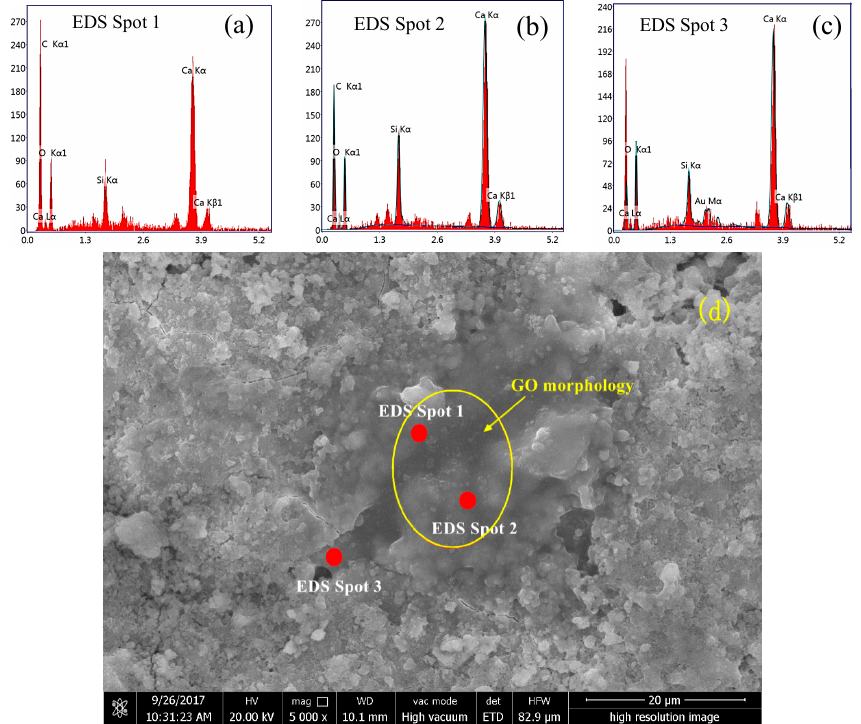
Figure 8. Microstructure analysis of GO-reinforced cement matrix at 28 days: ( a ) and ( b ) EDS for hybrid GO; ( c ) EDS for cement matrix; ( d ) SEM image of dispersion morphology of GO in cement matrix.